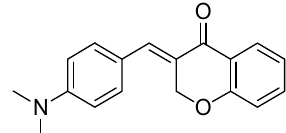
Figure 16. ( E )-3-(4-(Dimethylamino)benzylidene)chroman-4-one.